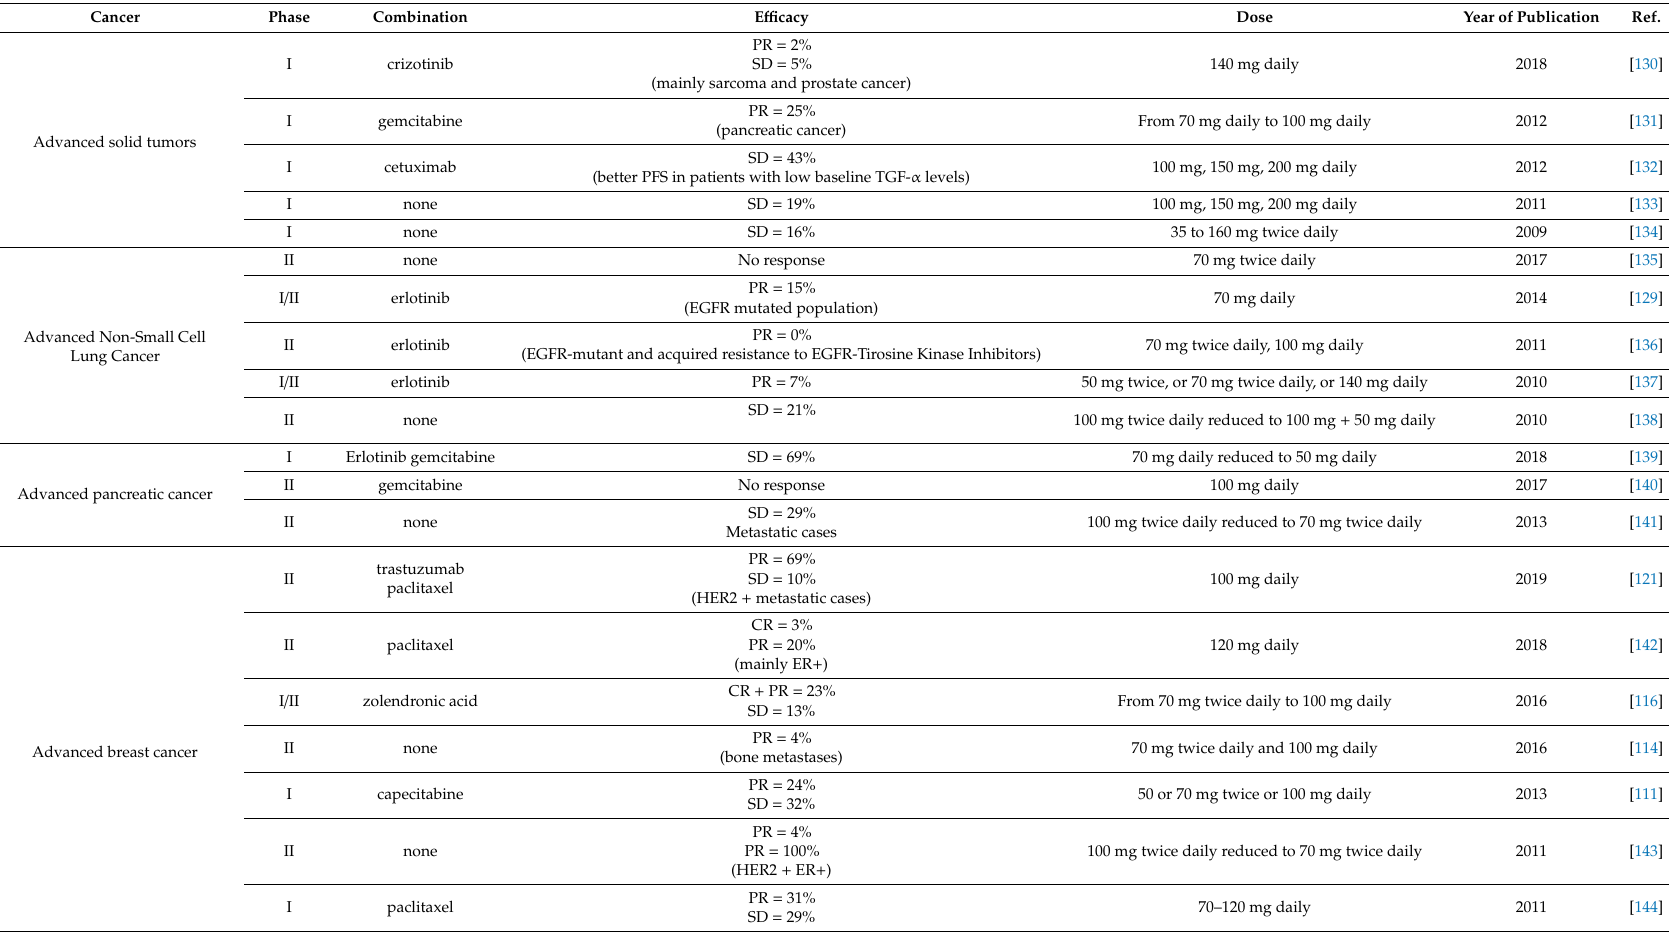
Table 2. Main characteristics of clinical trials designed in advanced solid tumors for the treatment with dasatinib alone or in combination with other drugs. E ffi cacy is to be considered as best clinical response, and when available, the population with the best response is indicated. PR = partial response; SD = stable disease; PFS = progression free